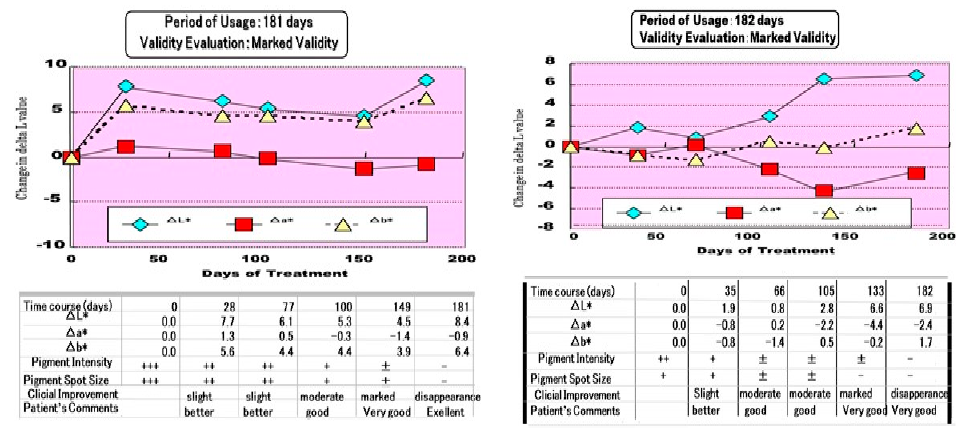
Figure 8. Two clinical cases where the SLs completely disappeared [1].